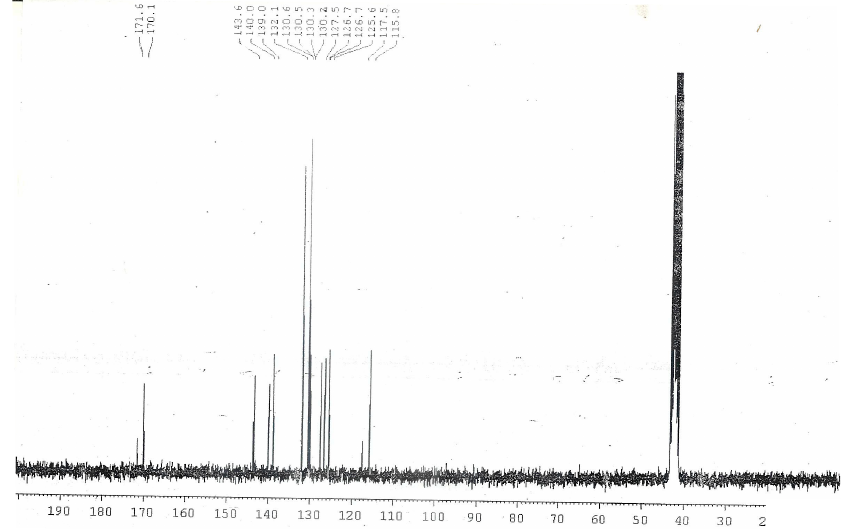
Figure 5. 13 C-NMR spectrum of NBTCS.